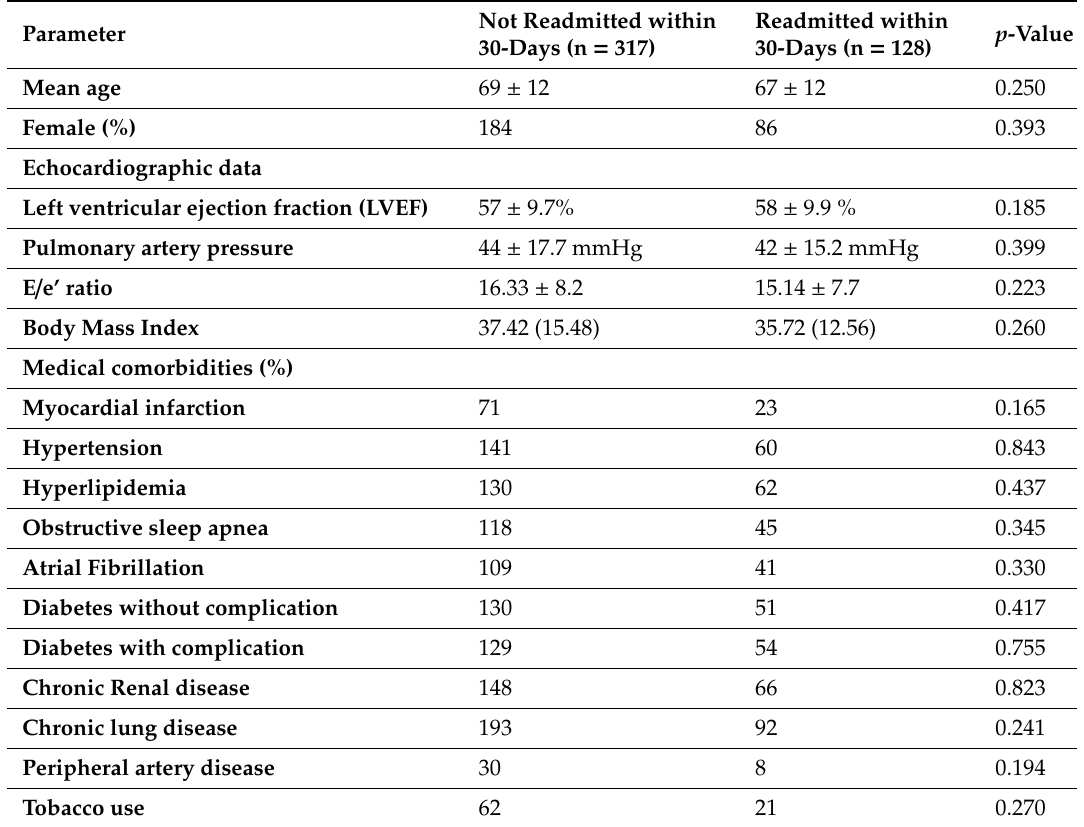
Table 1. Hospital admission characteristics of study population.